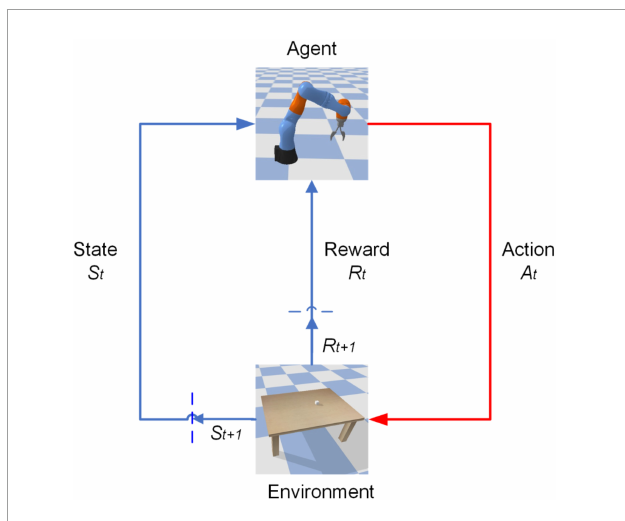
FIGURE2 Robotic arms interacting with the